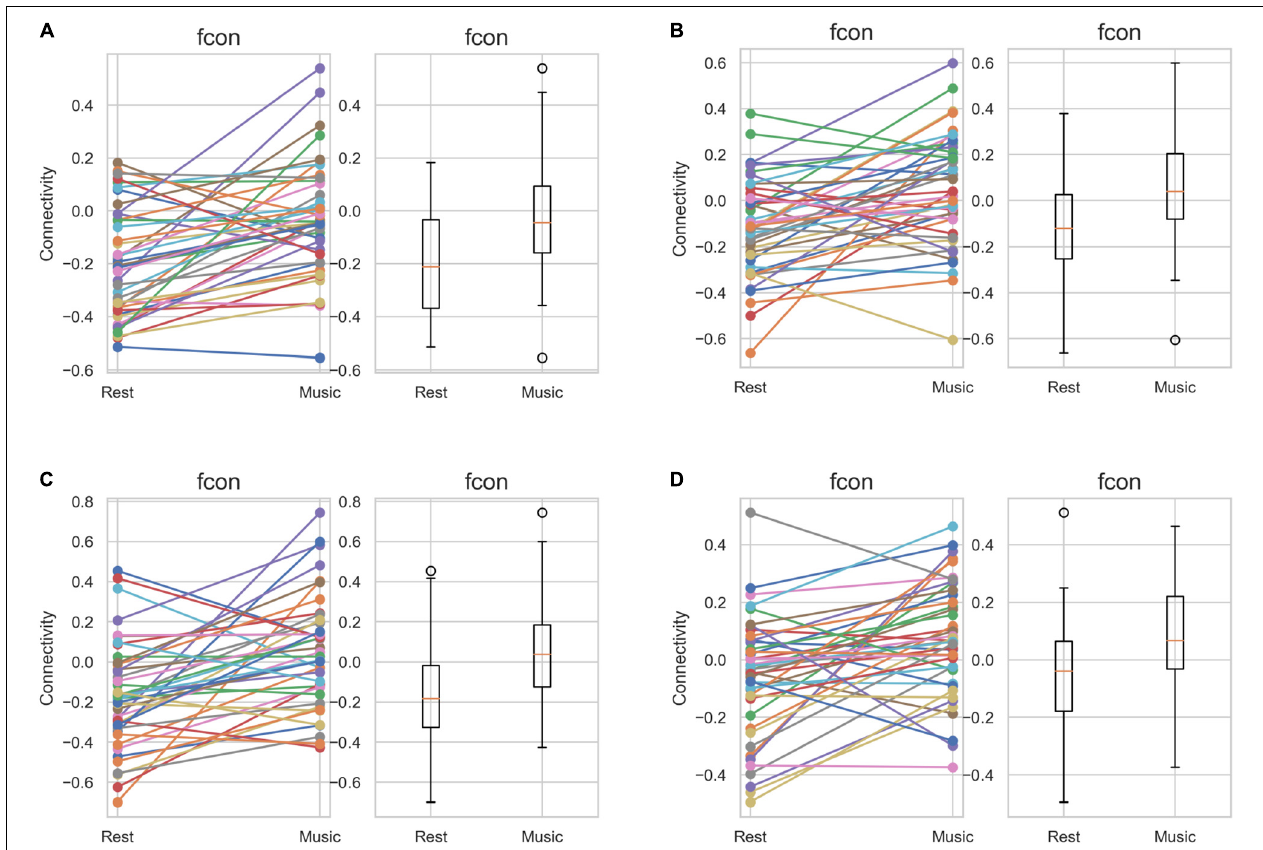
FIGURE 3 | Between-group comparison of the functional connectivity of the precuneus in the individual level. The results of all the 42 participants are depicted, distinguished by different colors. (A) left OFC ( t = 4.65, p = 0.000034), (B) left MFG ( t = 3.97, p = 0.00028), (C) left pSMG ( t = 4.39, p = 0.000077), and (D) left SFG ( t = 3.88, p = 0.00037). MFG, middle frontal gyrus; OFC, orbitofrontal cortex; pSMG, posterior supramarginal gyrus; and SFG, superior frontal